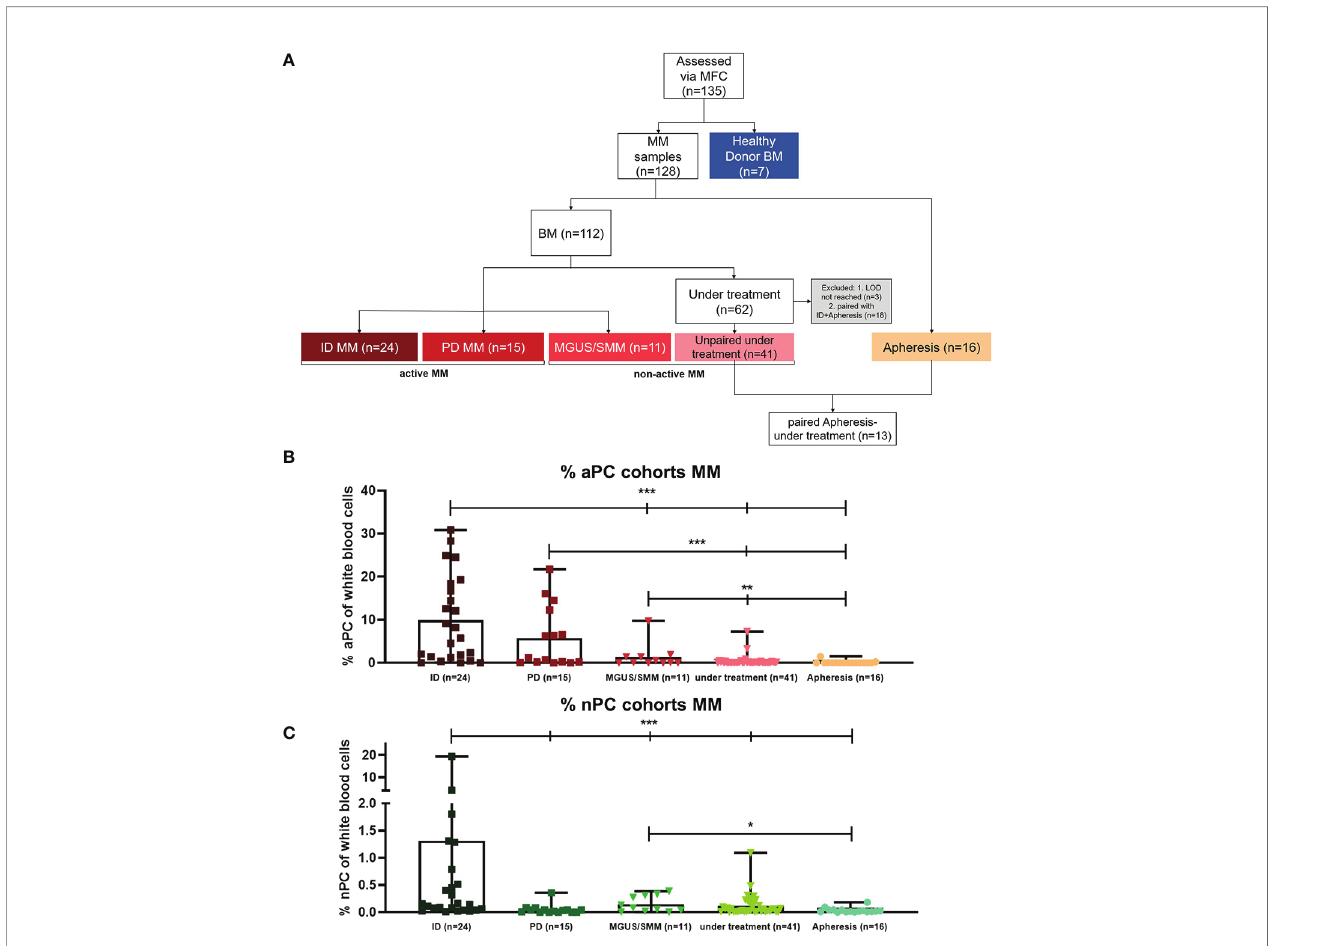
FIGURE 1 | Analyzed cohorts: patient sample fl ow diagram and percentage of aberrant plasma cells (aPC) and normal plasma cells (nPC) of different MM cohorts. (A) Flow diagram of the analyzed patient cohorts. A total number of 135 samples was analyzed. Apheresis (n = 16) and bone marrow (BM) (n = 112) samples of multiple myeloma (MM) patients were measured. Out of 112 BM samples, 24 were from patients presenting at initial diagnosis (ID), 15 from patients with progressive disease (PD), 11 from patients with monoclonal gammopathy of unknown signi fi cance (MGUS) or smoldering multiple myeloma (SMM), and 62 from patients under treatment. Three samples from patients under treatment were excluded because they did not reach the limit ofdetection (LOD). For the cohort comparisons, 18 patient samples had to beexcluded because they were pairedwith patients in other cohorts, bringing the number to 41 unpaired under treatment samples. Out ofthose 18 paired samples under treatment, 13 samples were paired follow-upsamples of patients that had been previouslyassessedat the time ofstem cellharvestin apheresis products. Formean fl uorescence intensity (MFI) analysis, some patients showedeither aPC or nPC populationsthat were below the LOD.Seven BM samples of healthy donors(HD) were examined. (B) Comparison of aPC percentages oftotalnucleated BMcells inthe investigated MMcohorts (p< 0.0070; p < 0.0001; Mann-Whitney U test). (C) ComparisonofnPC percentages oftotalnucleated BM cells inthe investigated MMcohorts (p< 0.0001; Mann-Whitney U test).***p < 0.0001; **p < 0.001; *p <